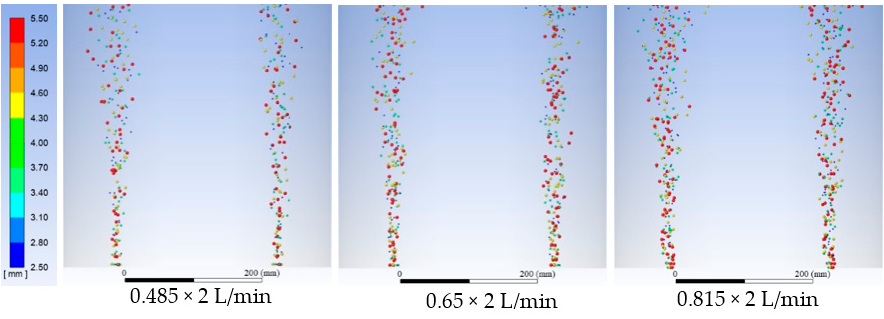
Figure 9. Color-dye path for a 1.63 L·min − 1 flow rate when using various radial-plug angles.